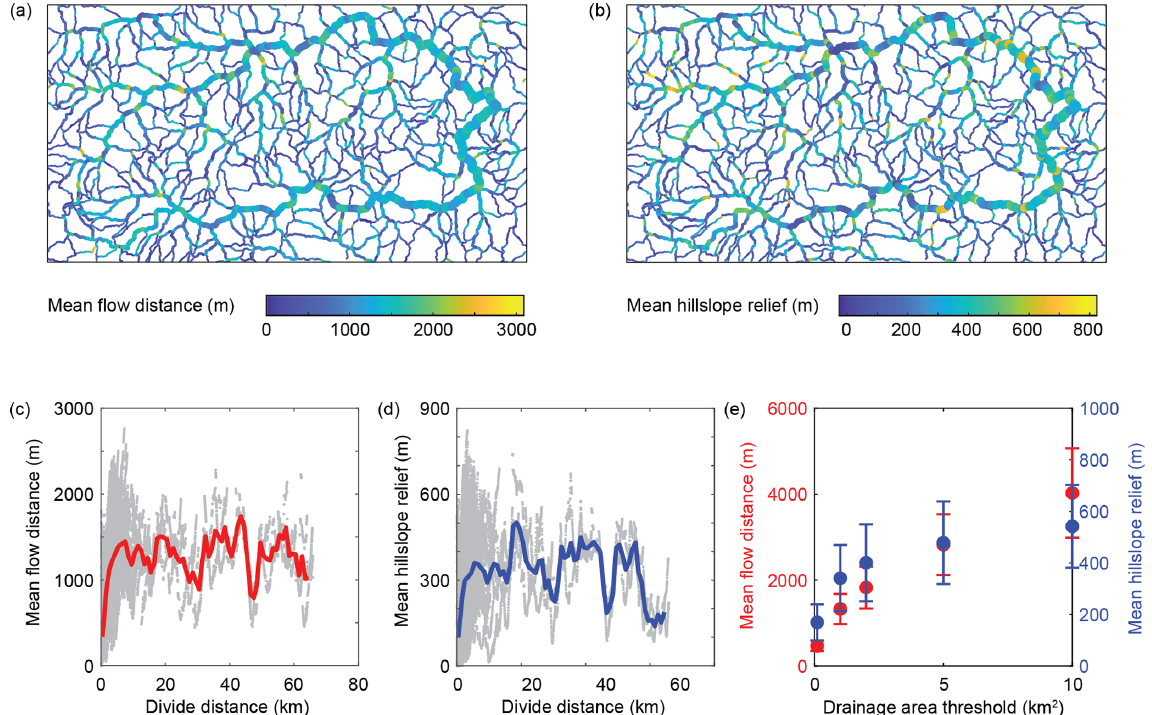
Figure 10. Drainage divide morphology of the Big Tujunga catchment based on a stream network that was derived from a drainage area threshold of 1km 2 . (a) Drainage divide network (DDN) colored by mean flow distance. Line thickness scales with divide distance. (b) DDN colored by mean hillslope relief. (c) Relationship between mean flow distance and divide distance of all divide edges in panel (a) . The red line shows a 1000m moving average. (d) Relationship between mean hillslope relief and divide distance of all divide edges in panel (b) . The blue line shows a 1000m moving average. (e) Average ( ± 1 σ ) values of mean flow distance (red) and mean hillslope relief (blue) for different drainage area thresholds. Average values were determined from all divide edges at a divide distance > 5km to minimize the influence of divides that are close to streams simply due to their proximity to confluences.